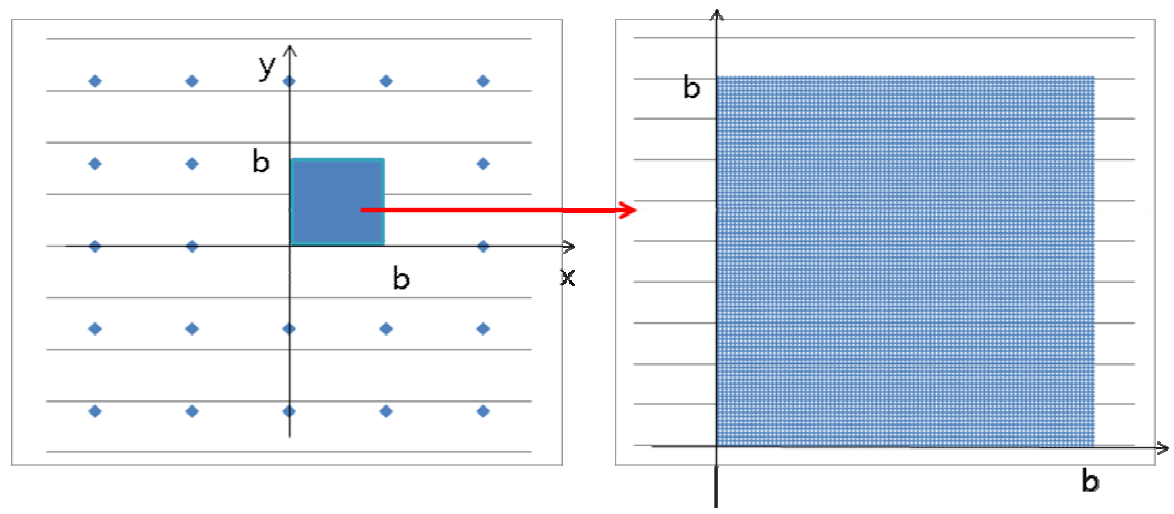
Figure 8. True values of simulation in 2-Dimensional